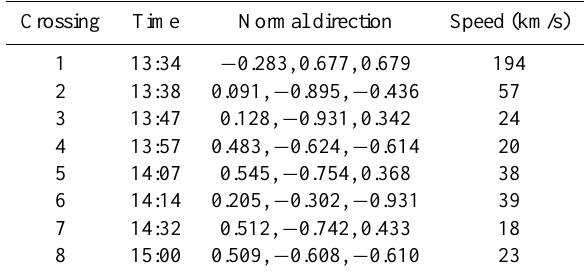
Table 1. Neutral sheet crossings on 5 August 2004 by Cluster.